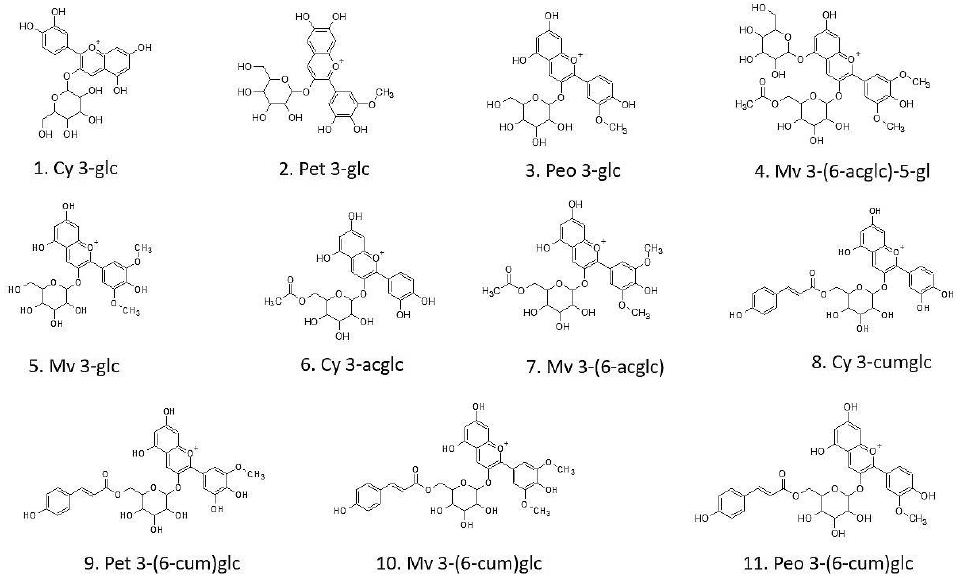
Figure 4. Characterization of identified anthocyanins in the order of elution time.